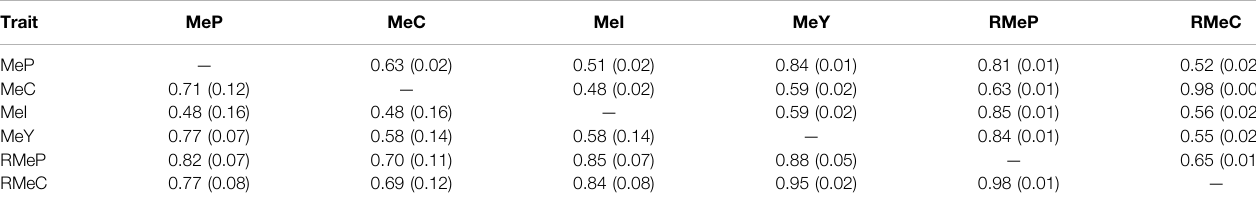
TABLE 3 | Estimated genetic (below diagonal) and phenotypic correlations (above diagonal) with (SE) between methane traits. Trait MeP